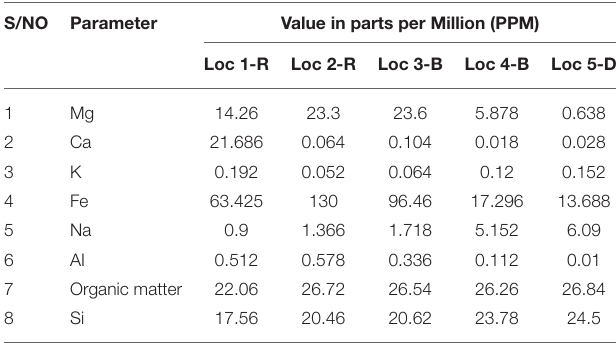
TABLE 6 | Chemical analysis of the treated active soil (Source: analysis of laboratory results). S/NO Parameter